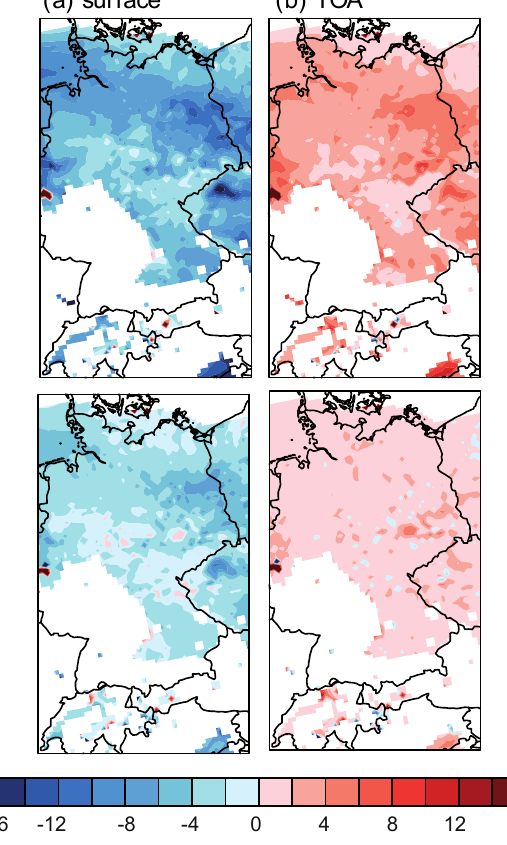
Figure 9. Direct radiative forcing in Wm − 2 for 3 April 2009 12:00 of BC at (a) the surface and (b) the top of the atmosphere, derived from the comparison of the runs with and without EC emissions. In (a) and (b) the upper panels refer to the run R3 using the unmodified imaginary part of BC in each case, whereas for the lower panels the adjusted value of 0.26 was